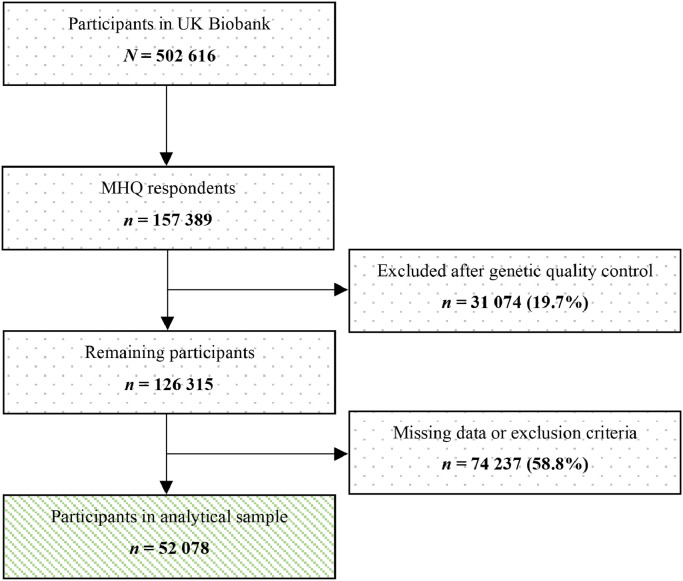
Flowchart of study sample.